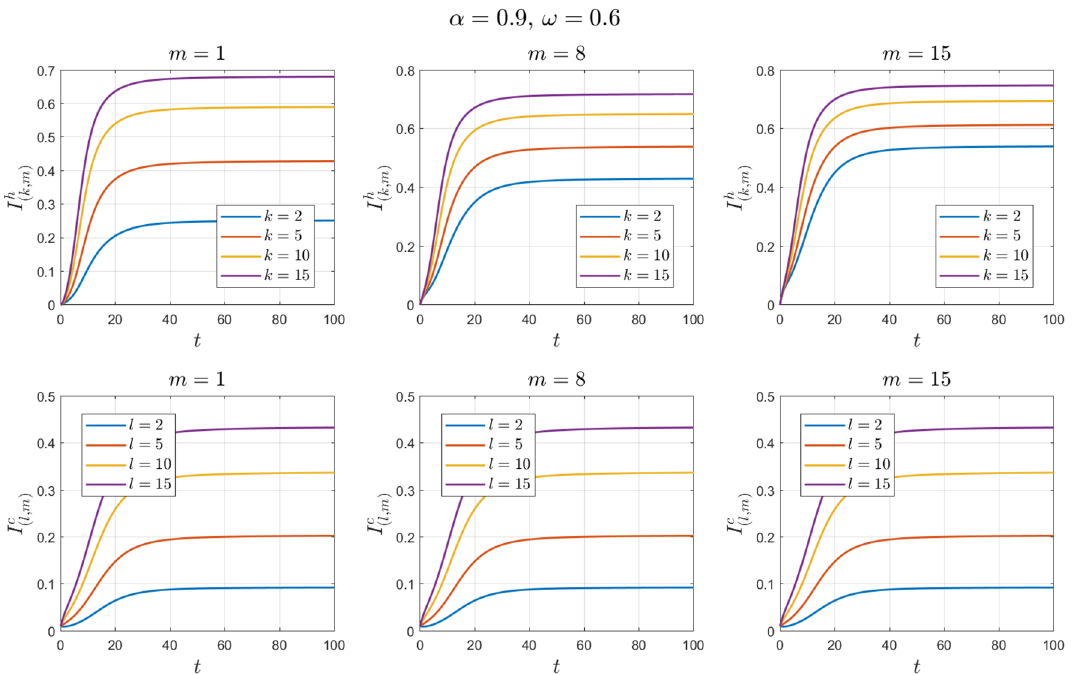
Figure 17. Numerical solutions of Example 5 for α = 0.9 and ω = 0.6